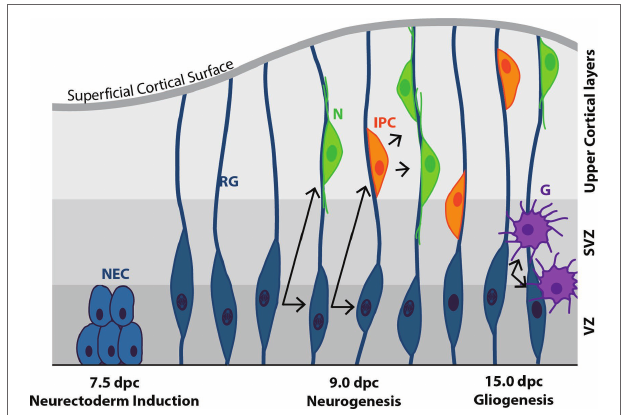
FIGURE 5 | Cortical neurogenesis in the mouse. Following neural plate formation at 7.5 dpc, neuroepithelial cells (NEC) differentiate into mitotically active neural progenitor cells known as radial glia (RG) by ~9.0 dpc. RG undergo either symmetrical division to produce two RG daughter cells, or asymmetric division to produce one RG daughter cell and a terminally- differentiated neuron (N), or an intermediate progenitor cell (IPC), or a mature glial cell (G). IPCs are capable of undergoing symmetrical division to form neurons. N and IPCs migrate along the axons of the RG cells from the ventricular zone (VZ), through the subventricular zone (SVZ) and into the upper cortical layers of the developing